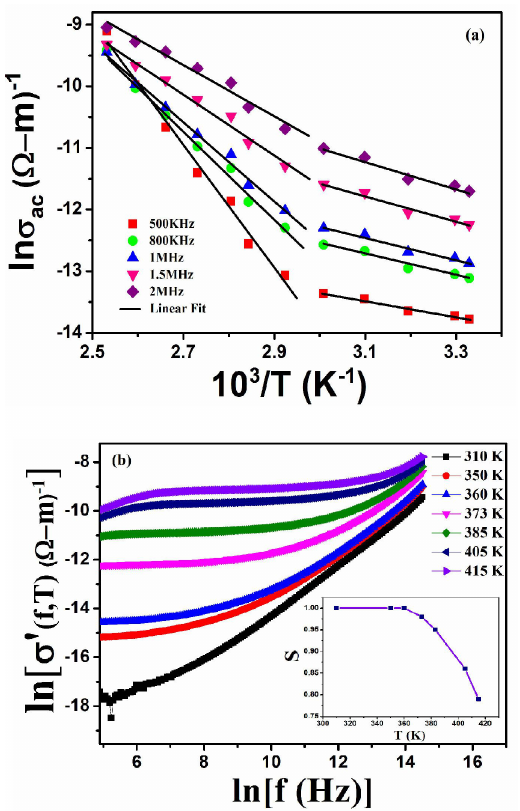
Figure 2: (a) AC conductivity variation with temperature of the sam- ple, (b) Frequency variation of AC conductivity (inset shows temper- ature variation of ‘ S ’).